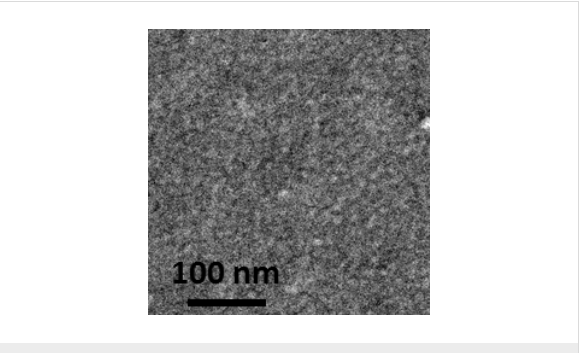
Figure 6: SEM image corresponding to CoFe PBA grown on the nanoperforated films without prior functionalization of TiO 2 .